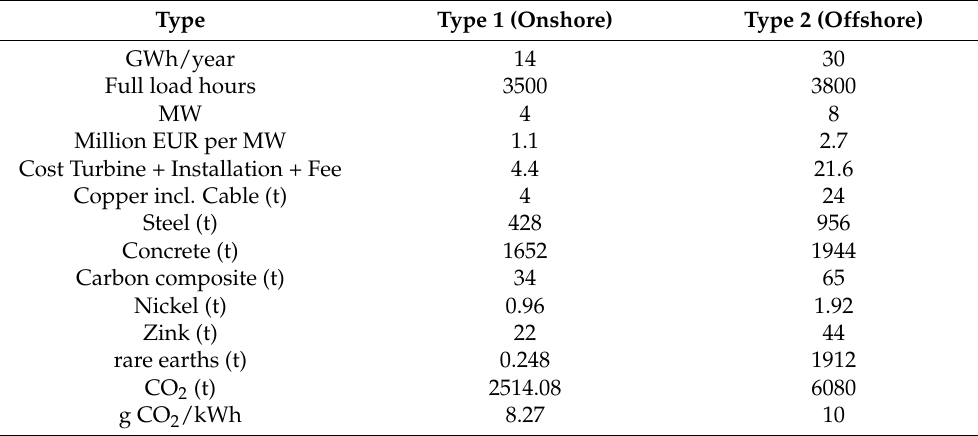
Table A1. Offshore vs. onshore turbines—a summary of costs and resource